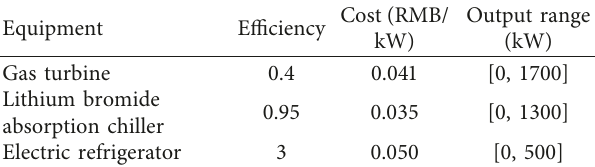
Table 1: Basic electrical load and cooling load. Table 2: Equipment operating parameters.